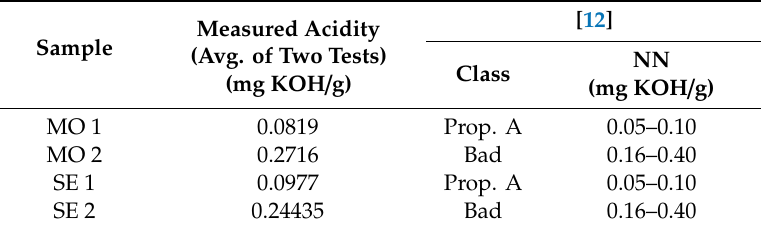
Table 1. Acidity details and class of the oil